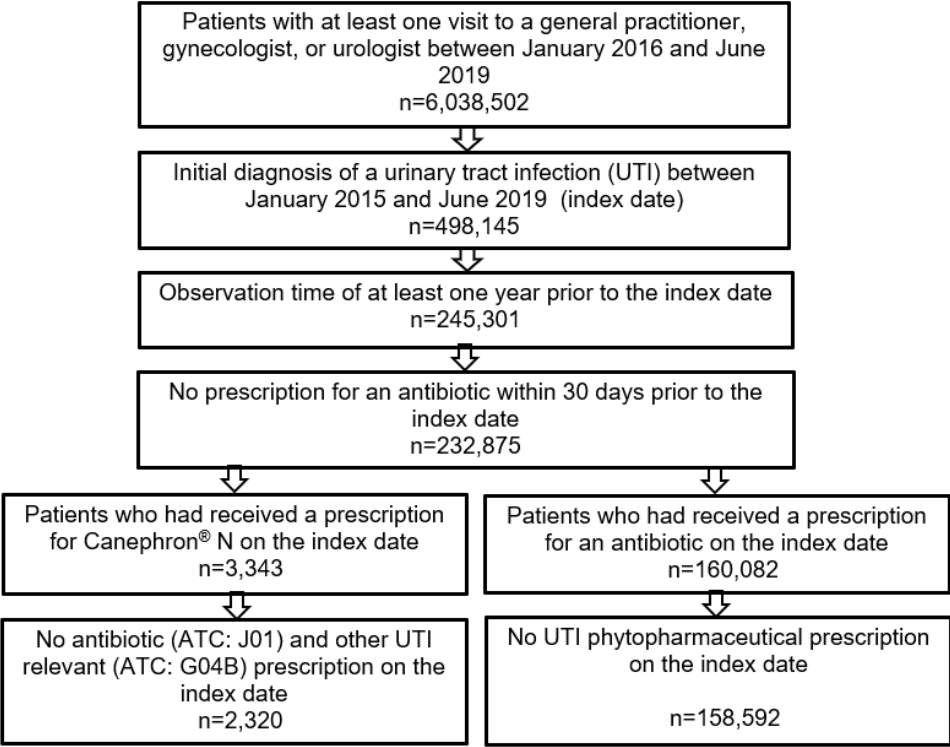
Figure 1. Selection of study patients.